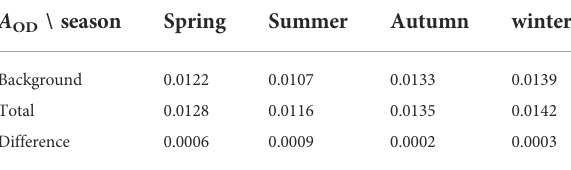
TABLE 1 Mean background and total stratospheric AOD values over Xinjiang from 2007 to 2018 by